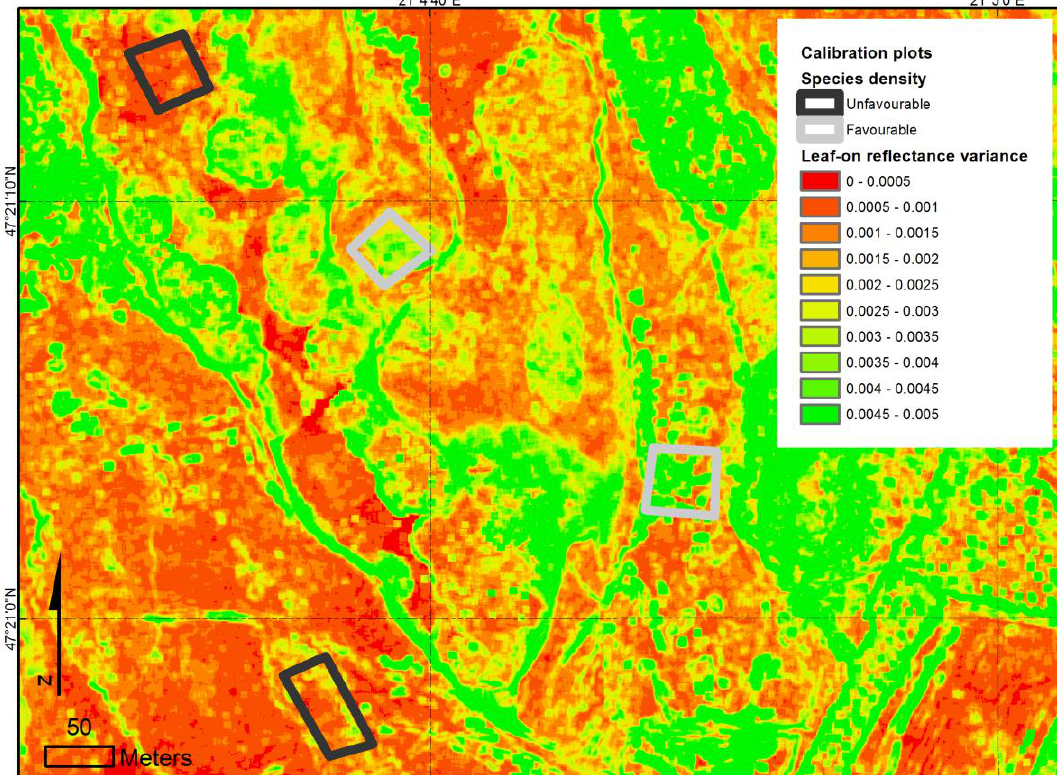
Figure 2: Fine-tuning threshold value for the conservation status variable "species density", represented by variance of leaf-on reflectance. According to this map the correct threshold value would be 0.002. Reproduced with permission from Zlinszky et